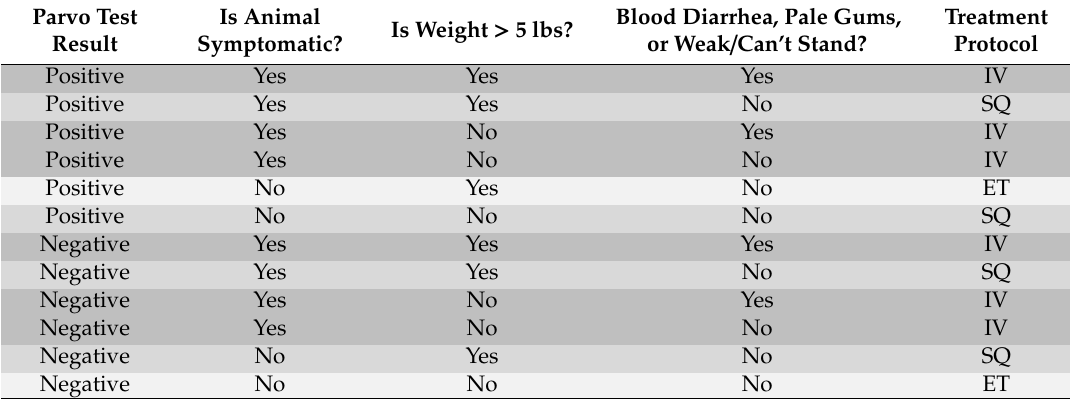
Table A1. The treatment flow / logic that defines which of the three treatment protocols is followed for an individual dog. Note that four of the rows are not possible as there is a contradiction between being asymptomatic and having severe symptoms. Shading indicates various treatment times (dark-to-light: IV (Intravenous), SQ (Subcutaneous), and ET (Exposed